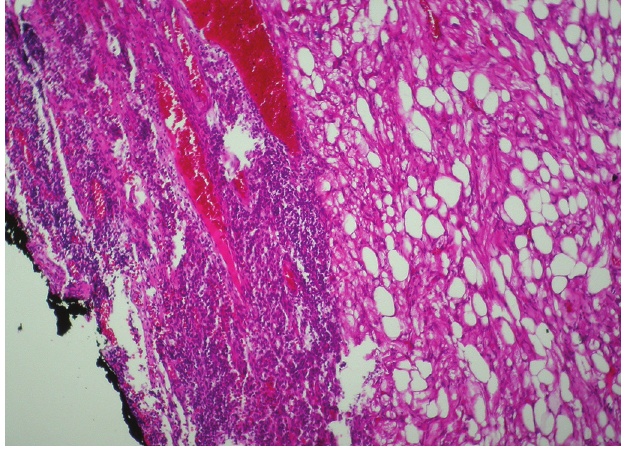
figurE 2 − Photomicrograph (HE staining, 10× objective lens): residual lymphoid tissue on the left and neoplasm on the right HE: hematoxylin and eosin.